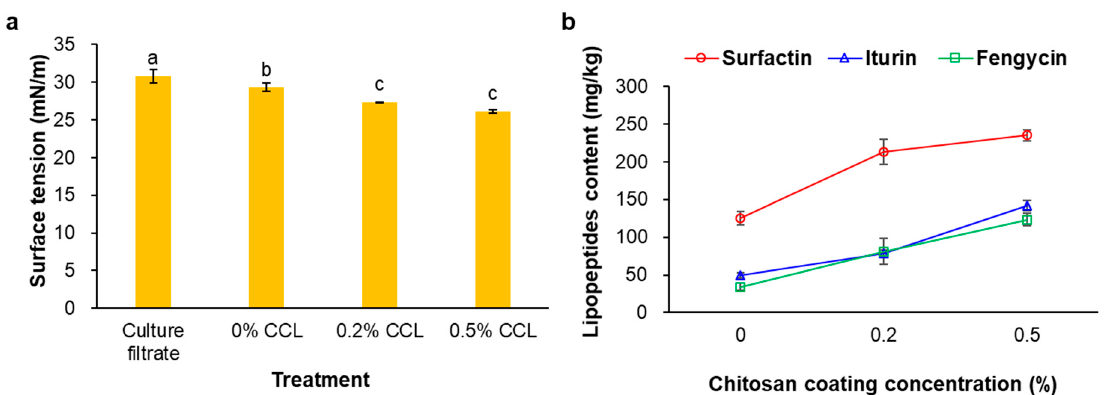
Figure 1. Surface tension ( a ) and CLP level ( b ) of the prepared CCL. The surface tension of water control was 73.2 ± 0.1 mN/m. Data represent means ± standard errors of three replicates. The values followed by different letters in a column were significantly different at p < 0.05 by Duncan’s multiple range